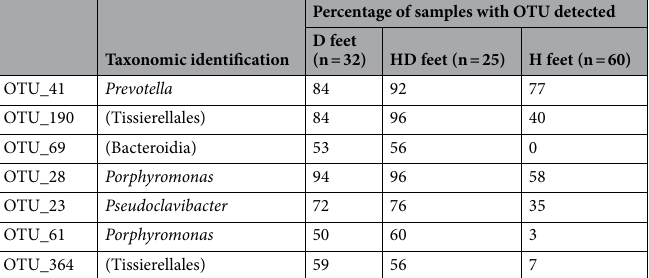
Table 1. Frequency of detection of seven OTUs used to predict disease status on D, HD and H feet in the period 2 + weeks before footrot occurred.